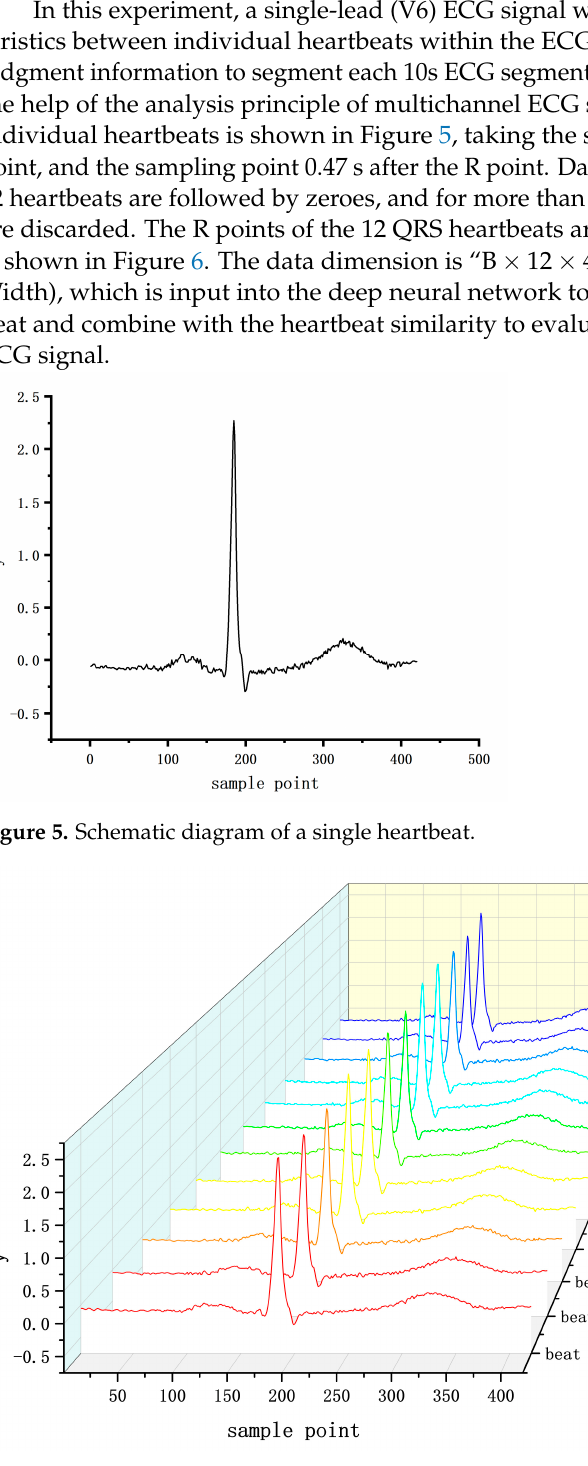
Figure 6. Schematic diagram of data after preprocessing.